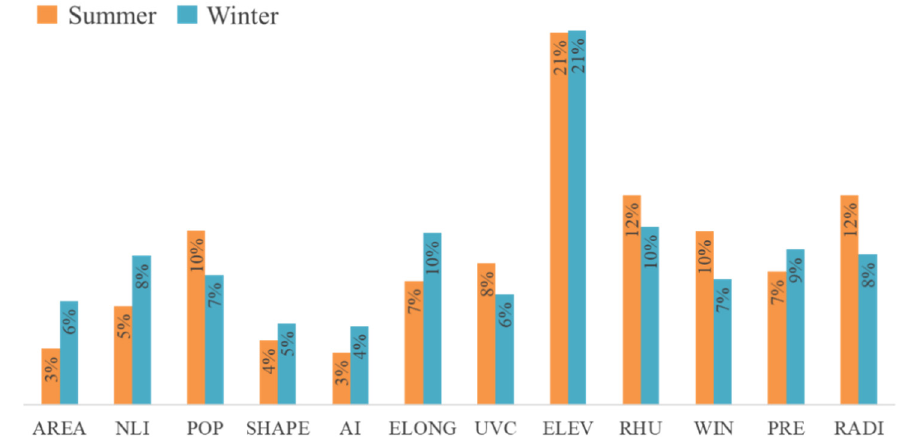
Figure 5. Contribution of all factors to the UTEI in summer and winter.